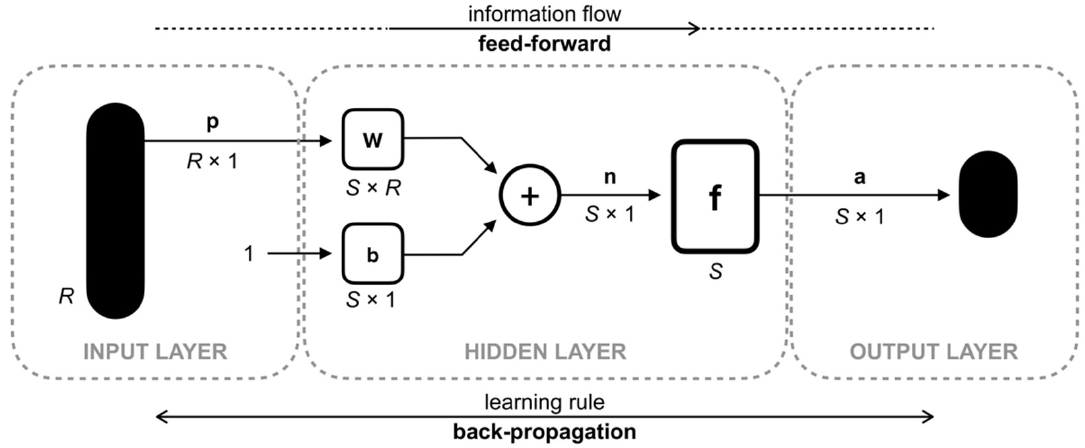
Figure 3. Scheme of a generic ANN of S neurons, adapted by [30].